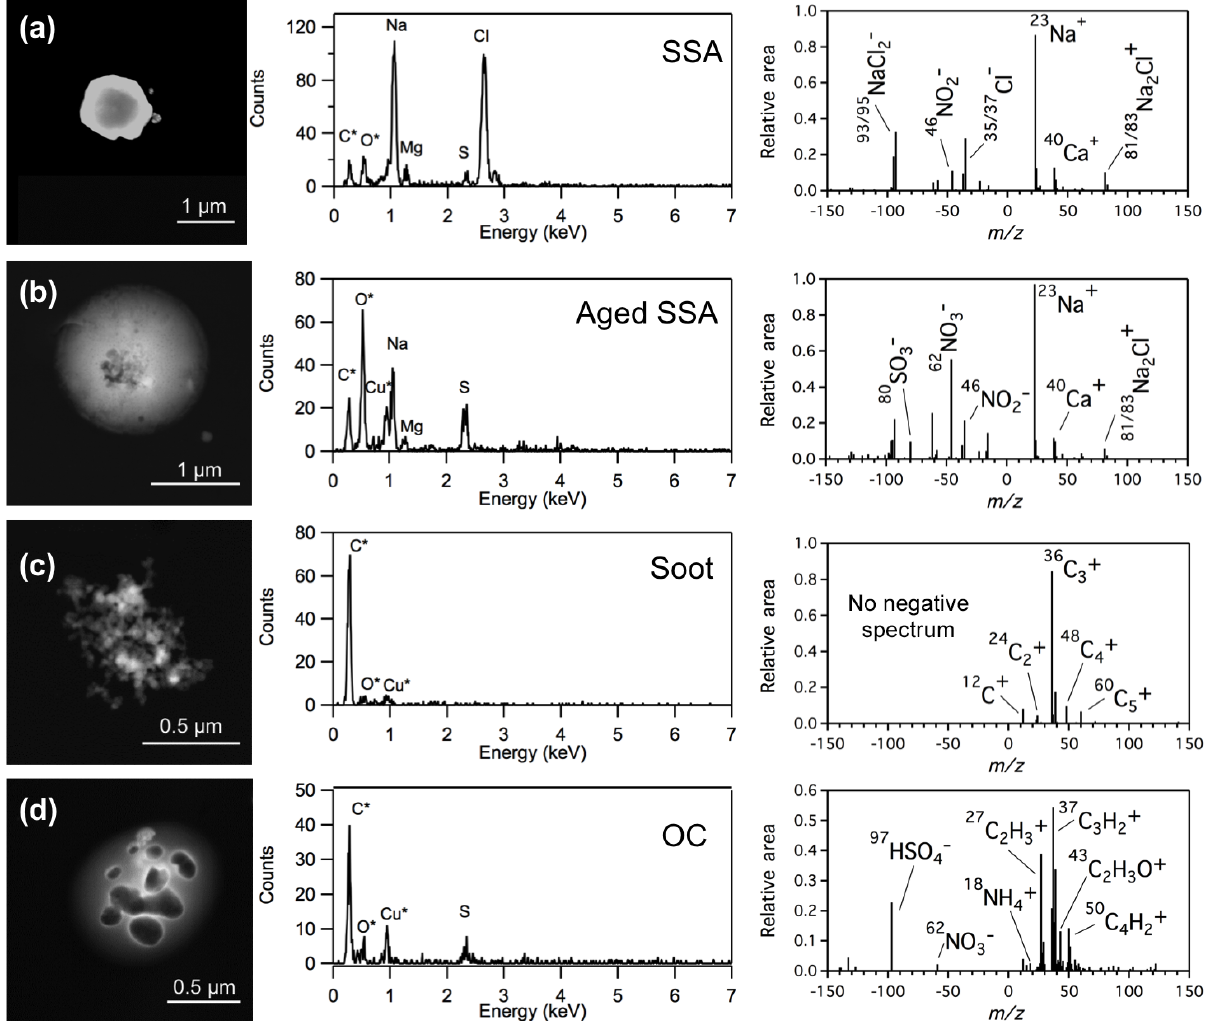
Figure 4. Representative SEM images (left) and EDX spectra (middle), as well as average ATOFMS mass spectra (right), for the major particle types observed: (a) sea spray aerosol (SSA), (b) partially aged SSA, (c) soot, and (d) organic carbon